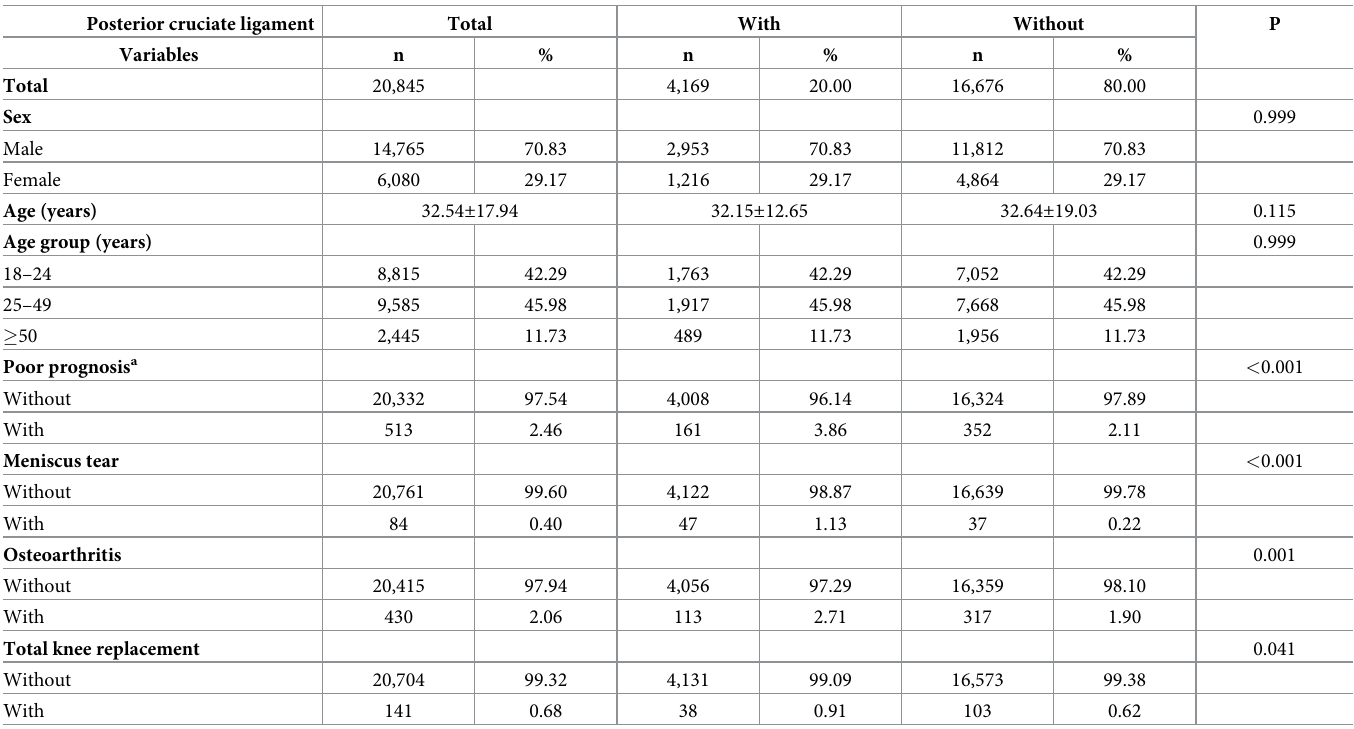
Table 1. Characteristics of patients with or without PCL injury. Posterior cruciate